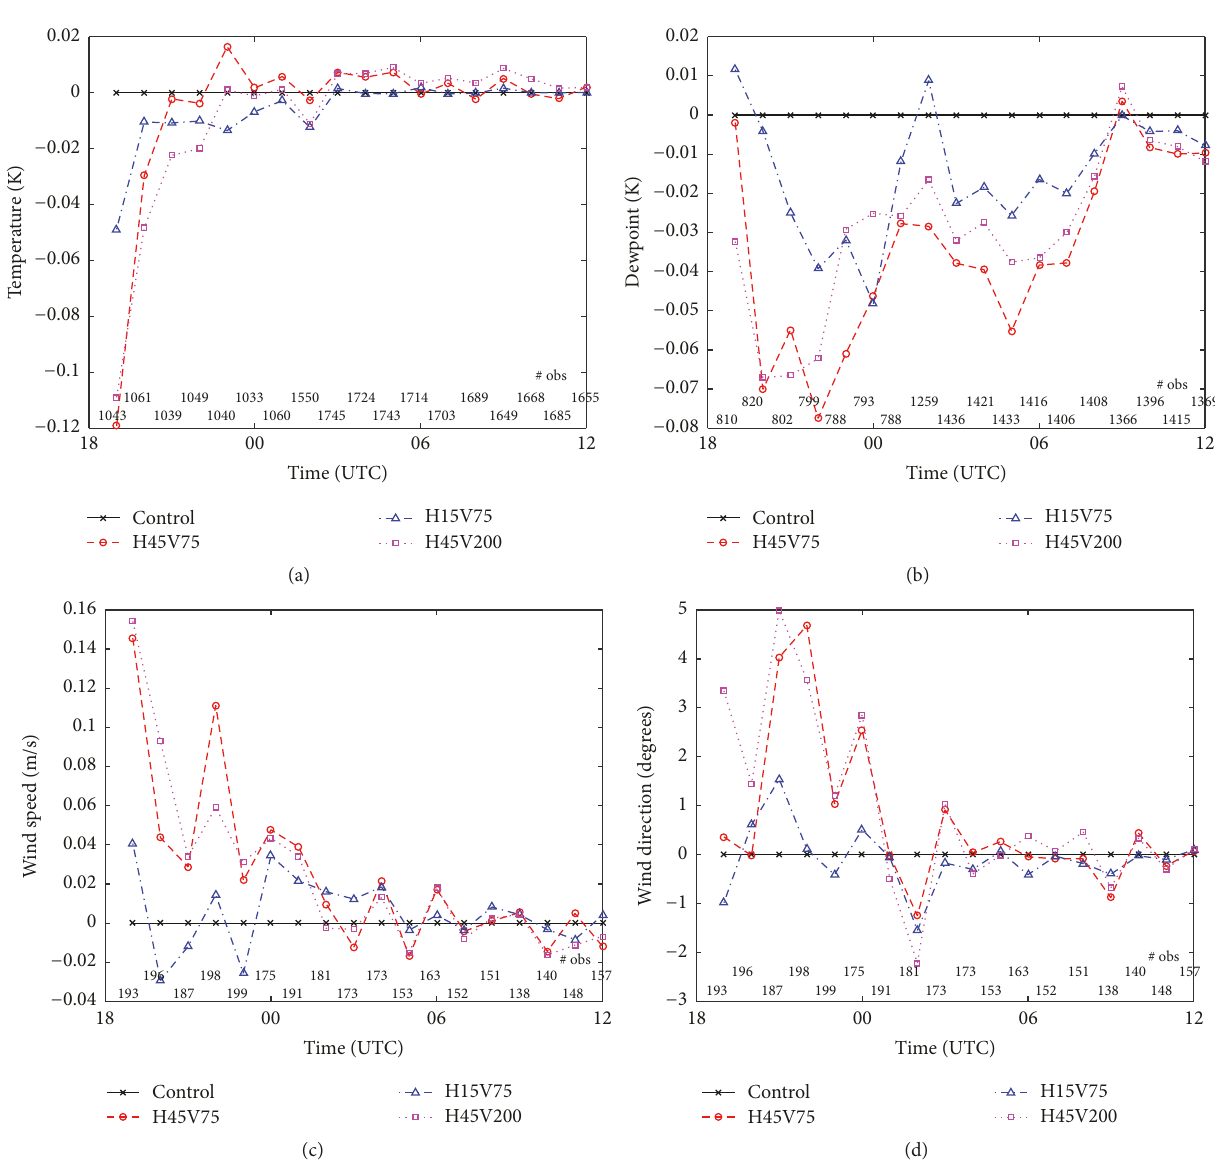
Figure 8: Time series of the difference between MAE for each experiment compared to the MAE for Exp. Control for the 1–18h forecast (19–12 UTC) for the surface calculated over observations from all five case days for (a) temperature, (b) dewpoint, (c) wind speed, and (d) wind direction. Values below the horizontal line indicate an experiment performed better than Exp. Control. The number of observations used to create the verification at each time is noted just above the horizontal axis at the bottom of the plot; the use of use-reject lists in the quality control contributes to significant variations in the number of observations available among variables and between night and